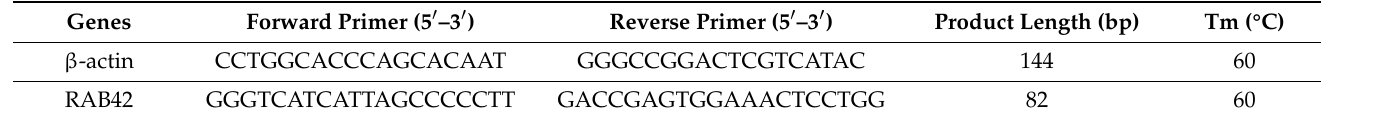
Table 3. Primer sequences for